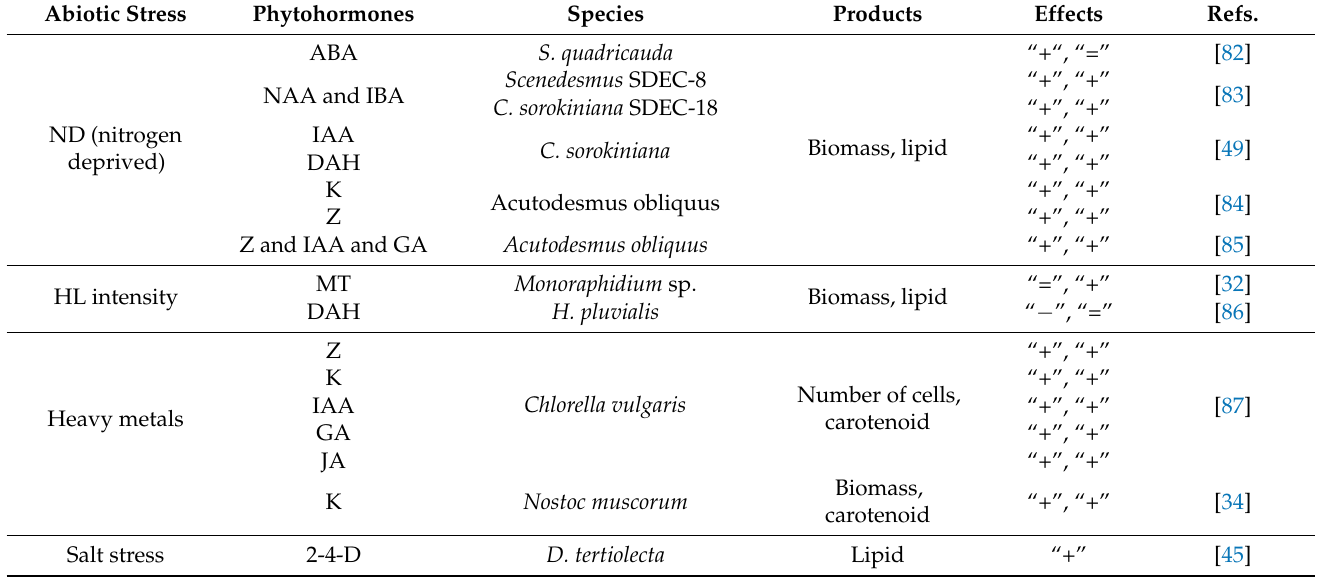
Table 2. Effect of phytohormones on the metabolites of microalgae under abiotic stresses. Abiotic Stress Phytohormones Species Products Effects